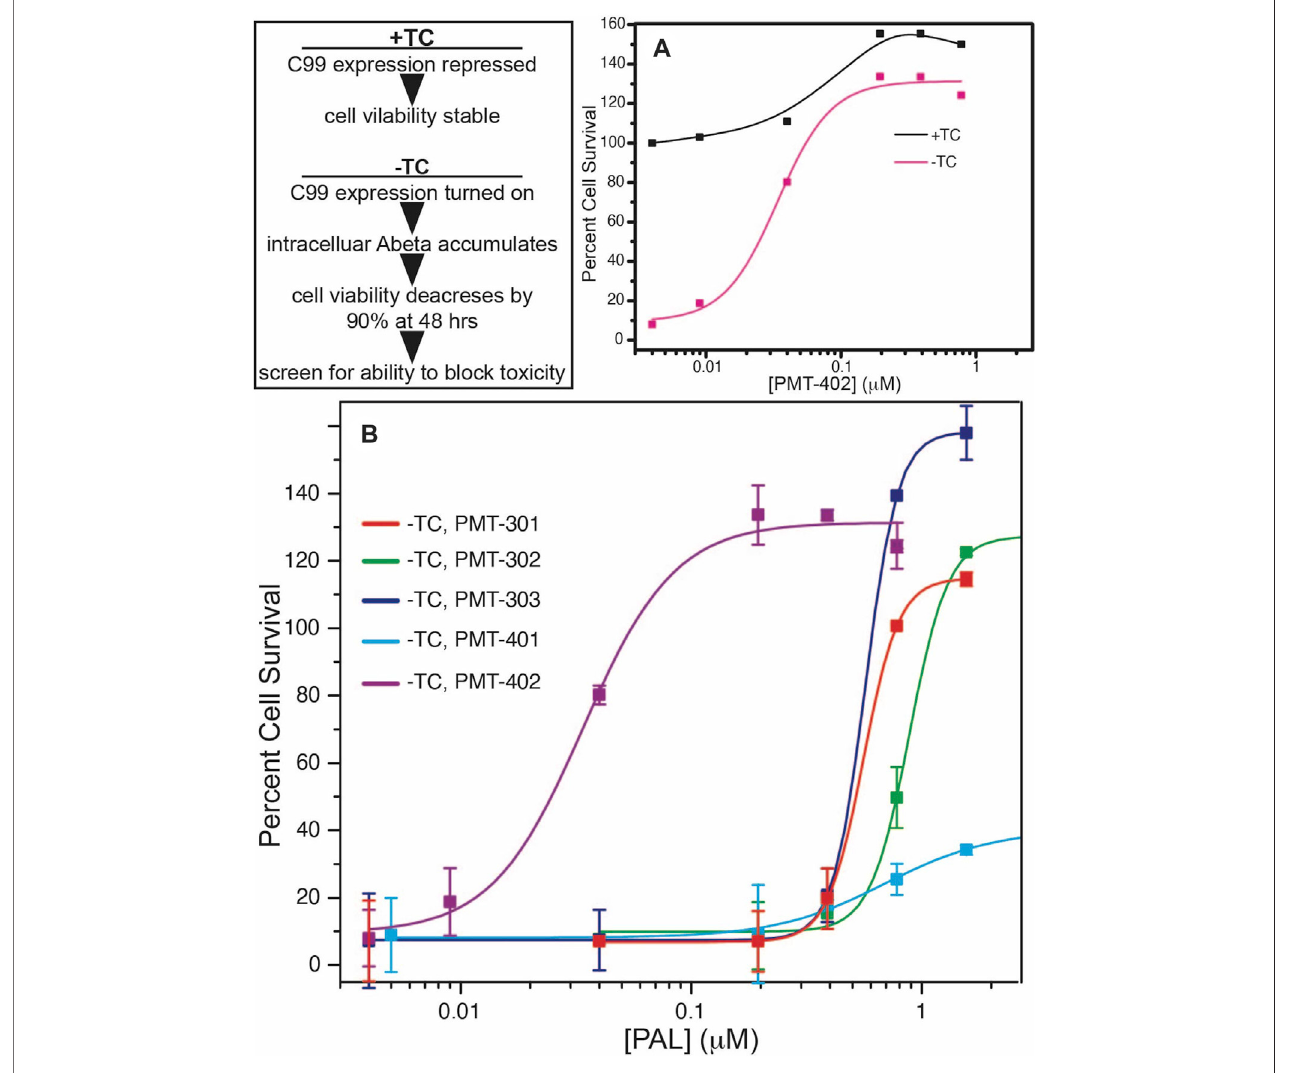
FIGURE 2 | Neuronal protection activity of the stilbene PAL agents in the MC65 model. Removal or tetracycline from the MC65 culture media results in C99 expression and amyloid beta cytotoxicity (A). (B) shows rescue of cytotoxicity with PAL titration. Error bars are the SEM from the assay of three separate cultures.